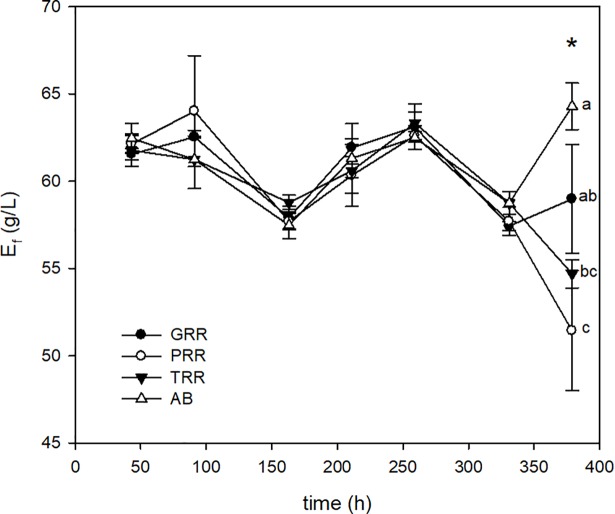
Evolution of ethanol concentration during ethanol fermentation for inorganic supports [glass Raschig rings (GRR), plastic Raschig rings (PRR), tygon Raschig rings (TRR) and alumina beads (AB)] during 7 fermentation cycles (Li = 130 g/L) employing K. marxianus DSM 5422.Asterisks indicate the existence of significant differences (p < 0.05) among supports for a given batch. If two supports share one letter (a, b or c), there are no significant differences between them.